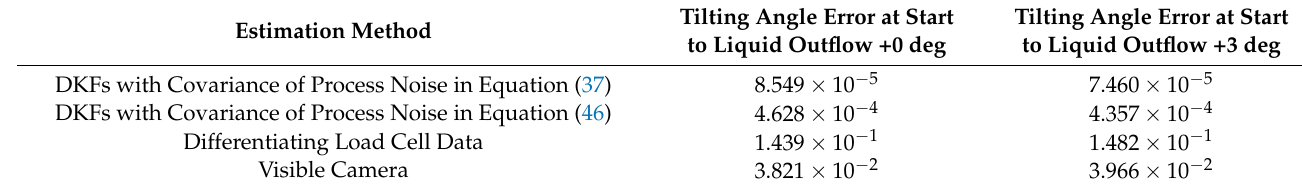
Table 3. Modified total variations (mTVs) of estimated flow